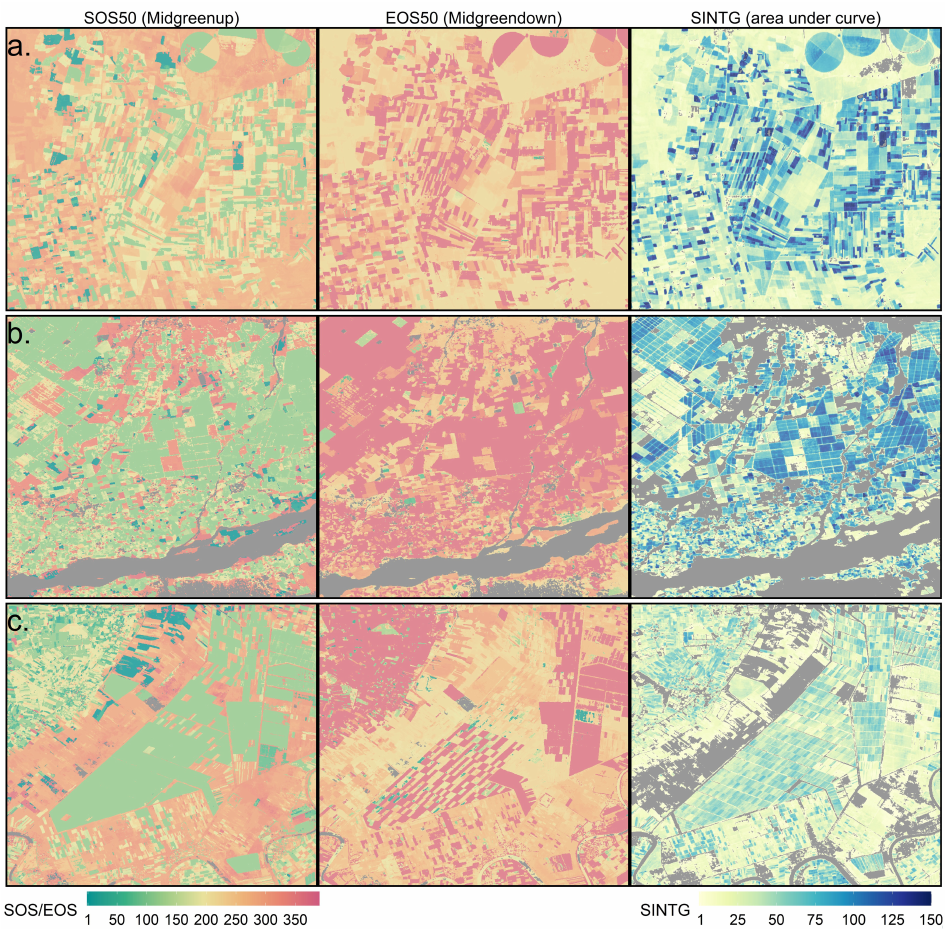
Figure 8. Detailed spatial pattern of SOS50 (MidGreenup), EOS50 (MidGreendown), and SINTG (EVI2 curve integral) derived from 10 m Sentinel-2 EVI2. The DOY (Day of Year) of SOS and EOS begins on the 1 September of each year. The boxes labelled ( a – c ) are the areas indicated in Figure 7. Geographic variation in mid-green-down timing (EOS50) is similar to SOS50